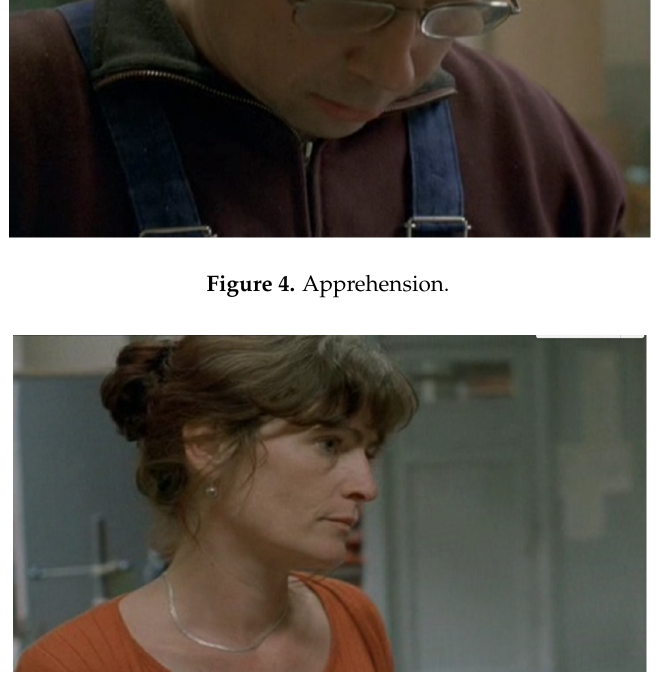
Figure 5. Apprehension. Figure 5.